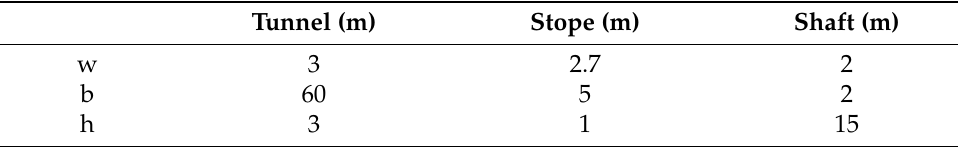
Figure 5. Cross-sectional diagram of the tunnel, stope, and shaft. Table 1. Dimensions of the experimental